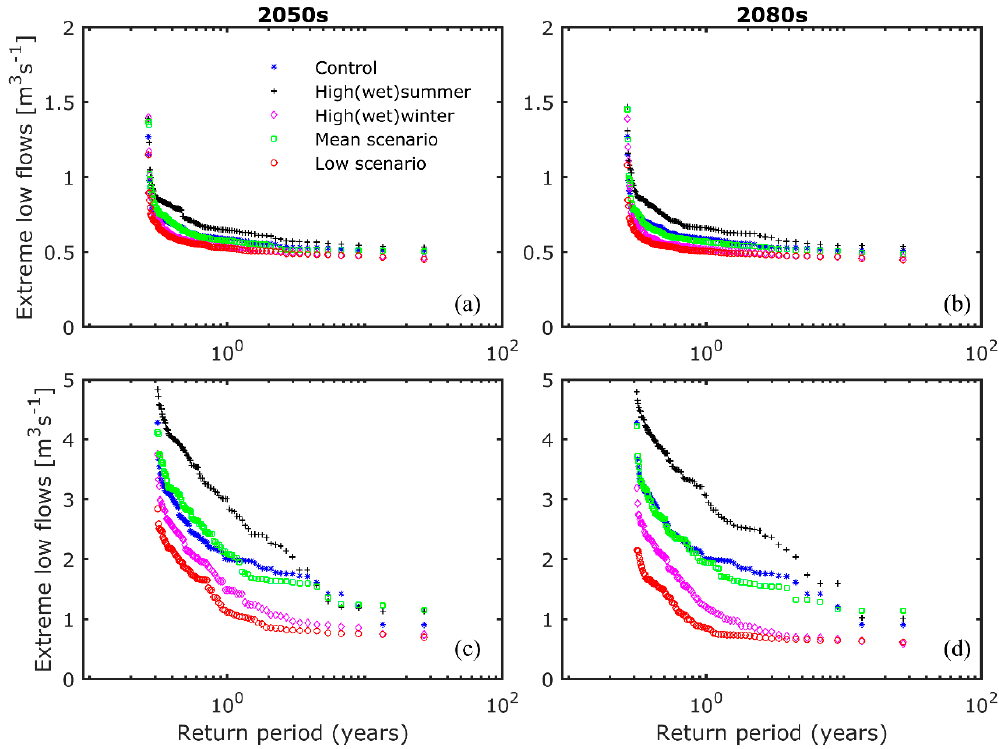
Figure 6 . Simulated extreme low flows of Zenne for control and four climate change scenarios at Tubize ( a , b ) and Lot ( c , d ), showing the downstream part of the basin is more sensitive to climate change, especially by the end of this century.